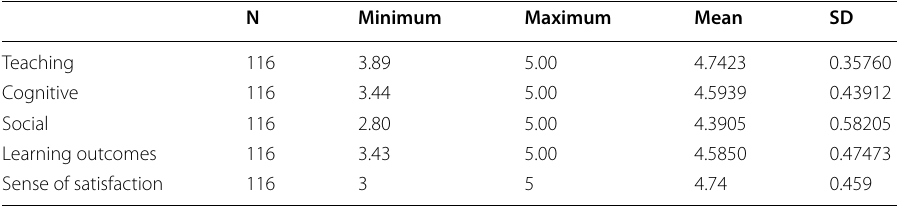
Table 1 Descriptive statistics